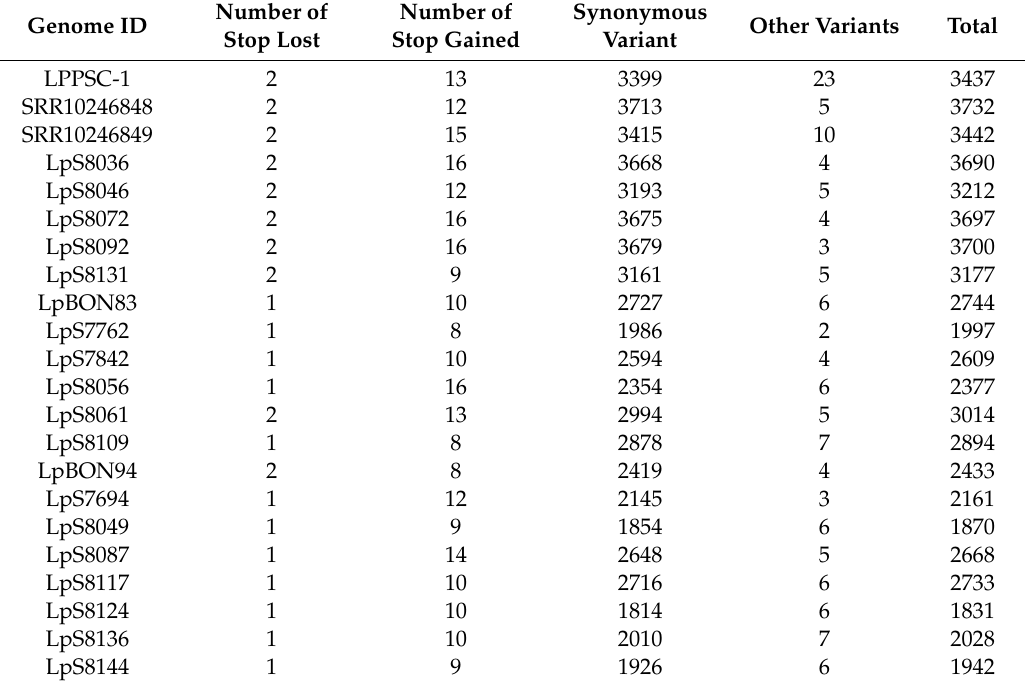
Table 2. Selected set of SNPs with synonymous variant e ff ect or relevant impact on gene